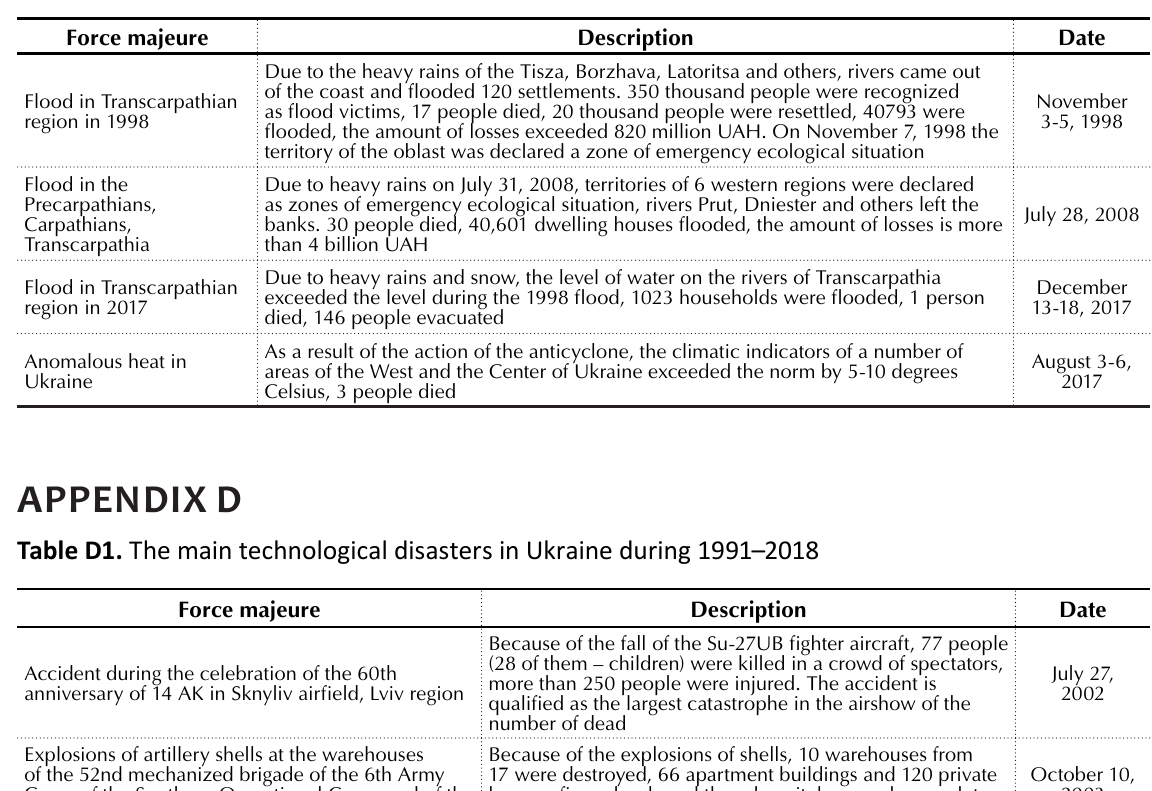
Table C1. The main natural disasters in Ukraine during 1991–2018